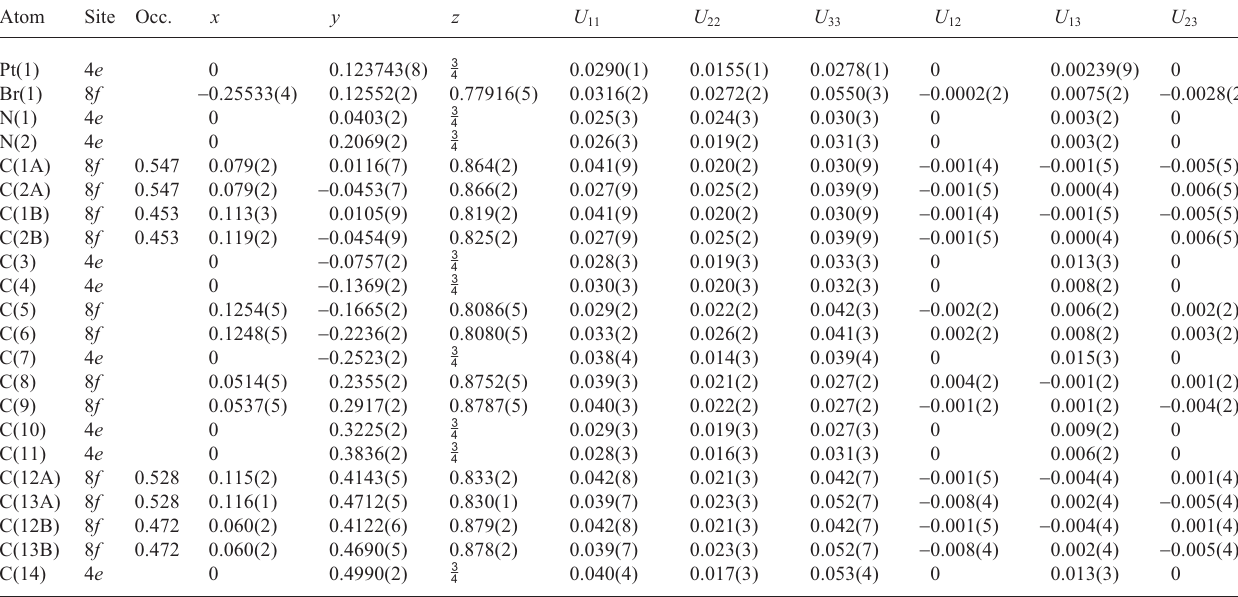
Table 3. Atomic coordinates and displacement parameters (in Å 2 ) . Atom Site